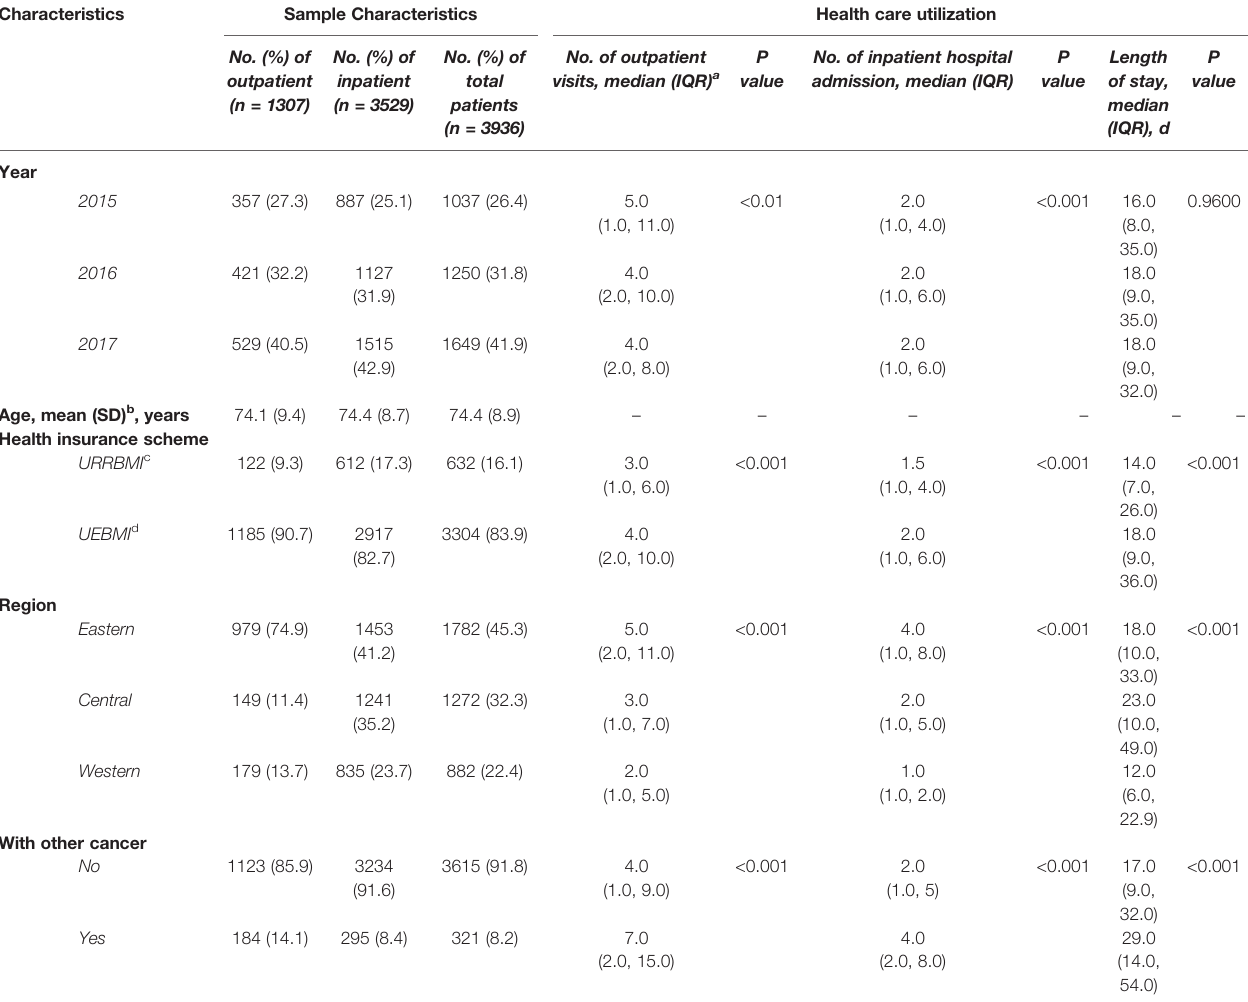
TABLE 1 | Characteristics and health care utilization of patients with prostate cancer.